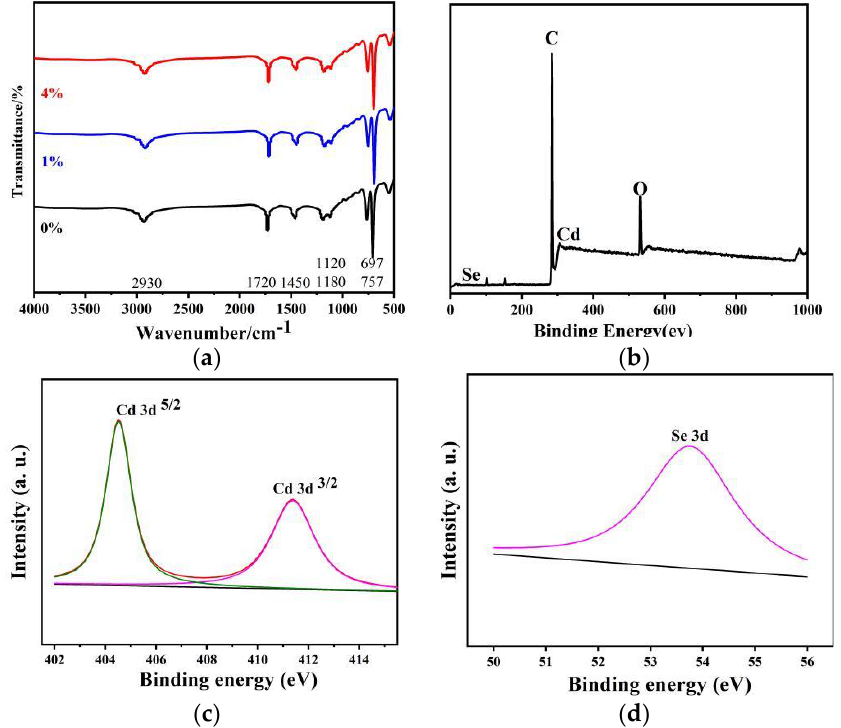
Figure 6. ( a ) FTIR spectra of the P(S+MMA) and CdSe@P(S+MMA) hybrid fibers. ( b ) XPS wide scan spectrum of CdSe@P(S+MMA) hybrid fibers. XPS narrow scan spectrum for Cd 3d ( c ) and Se 3d ( d ) regions.